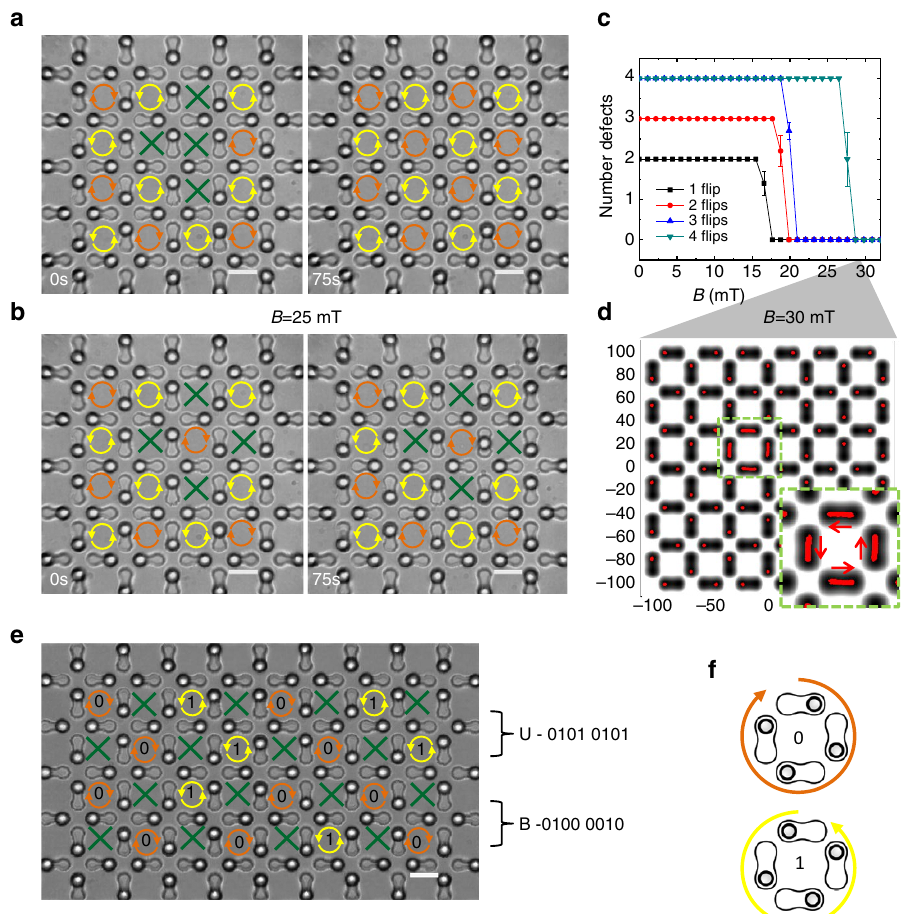
Figure 4 | Defect stability and binary writing procedure. ( a , b ) Microscope images showing the evolution with time of three ( a ) and four ( b ) achiral cells in a square lattice when subjected to a static field of B ¼ 25mT. Flipping three spins is necessary in a to reach the ground state, while in b the defect arrangement requires the inversion of the chirality of the central cell, which is energetically more expensive. ( c ) Reduction of defects versus applied field obtained from numerical simulation. At a field of B ¼ 30mT, ( d ) the simulation shows that it is possible to drive the system to its ground state by the simultaneous flipping of all four particles, inverting the cell’s chirality. Inset shows an enlargement of the central cell. ( e ) Example showing the word ‘UB’ written in a square ice using the binary ASCII representation (8 bit). ( f ) Schematic showing how it is assigned a value of 0 (1) to a clockwise (counterclockwise) chiral cell. Bits in e are read from left to right and from top to bottom. Scale bars, 20 m m for all (Thorlabs) with a 100 (cid:3) Achromatic microscope objective (Nikon, numerical aperture ¼ 1.2) which is also used for observation purpose. During the experiments, a solution is prepared with 3.5 m l of polystyrene paramagnetic particles (PS-MAG-S2874Microparticles GmbH) with 10ml of high-deionized water (MilliQ system, Millipore). A drop is placed on the soft lithography structures and after few minutes, the particles sediment due to density mismatch until they are suspended above the substrate due to the electrostatic repulsive interactions with the negative charged surface. We use the optical tweezers to fill all the bistable traps with exactly one particle, removing excess or aggregated colloids. After the initial setting, the particles are allowed equilibrate in their wells for B 2min before applying the external field. We place a total of 84 particles in the square lattice and 64 in the honeycomb lattice in an experimental field of view of 325 (cid:3) 222 m m 2 . The effect of the boundary on the experimental system is discussed in Supplementary Note 3 and shown in Supplementary Fig. 6. Brownian dynamics simulation . We perform two-dimensional Brownian dynamics with periodic boundary conditions containing N particles arranged into an ensemble of double-well traps. A particle i at position ~ r i (cid:4) x i ; y i ð